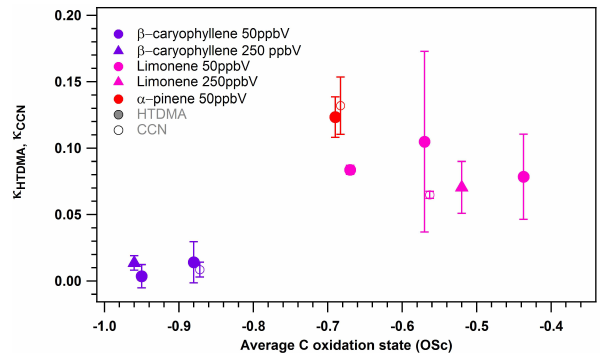
Fig. 11. κ HTDMA values average over the final hour for the largest measured size and κ CCN of the appropriate experiments plotted against average C oxidation state calculated from SOA filter sam- ples collected at the end of same experiments. The filled and open symbols are for HTDMA and CCN data, respectively. The κ CCN data points have been offset very slightly to the right for display